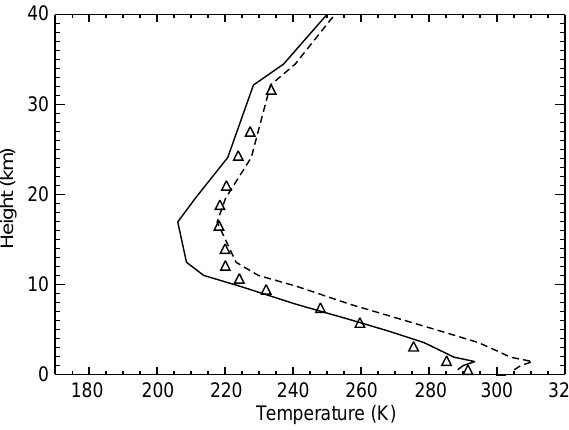
Fig. 7. Modelled temperature profiles for July with ( solid ) and without ( dashed ) advection compared to radiosonde measurements ( triangles )